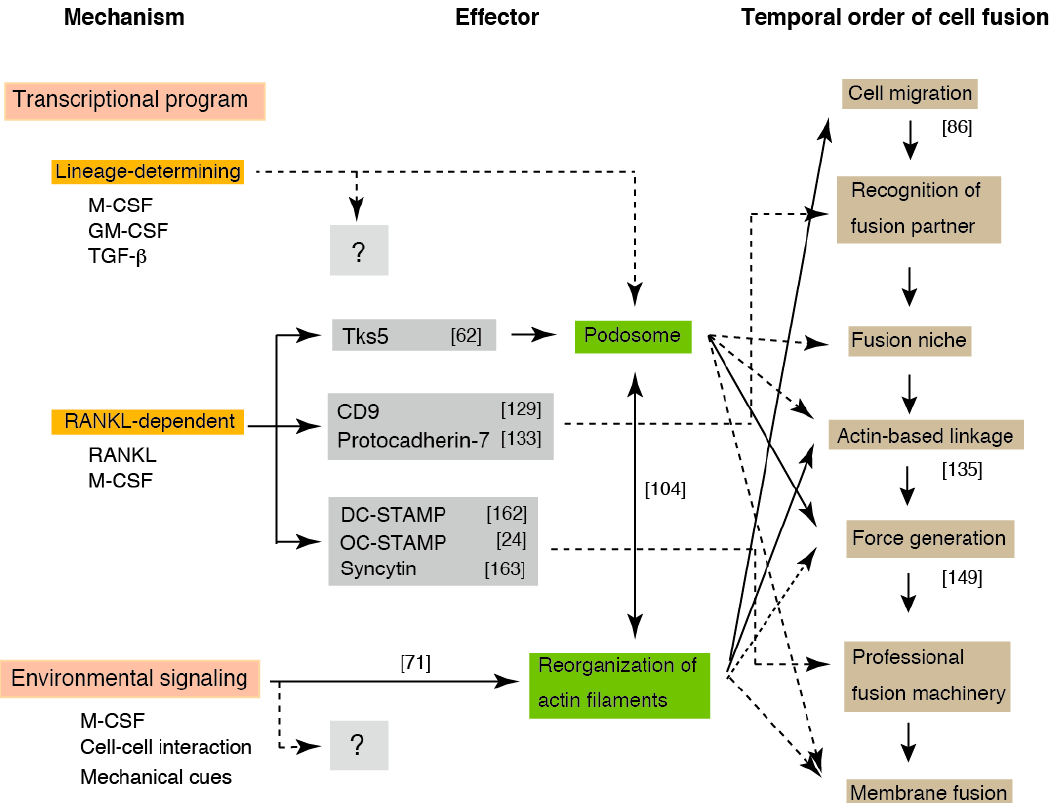
Figure 4. Schematic of the layered mechanism of osteoclast multinucleation. Osteoclast multinucleation is regulated by three interdependent signals. The solid and dashed lines indicate the experimentally demonstrated (specified by the reference number cited in the text) and not demonstrated events, respectively. The fusion-related molecules produced by the lineage-determining program and environmental signaling have not been identified. DC-STAMP: dendritic cell-specific transmembrane protein, OC-STAMP: osteoclast stimulatory transmembrane protein, Tks5: tyrosine kinase substrate with five SH3